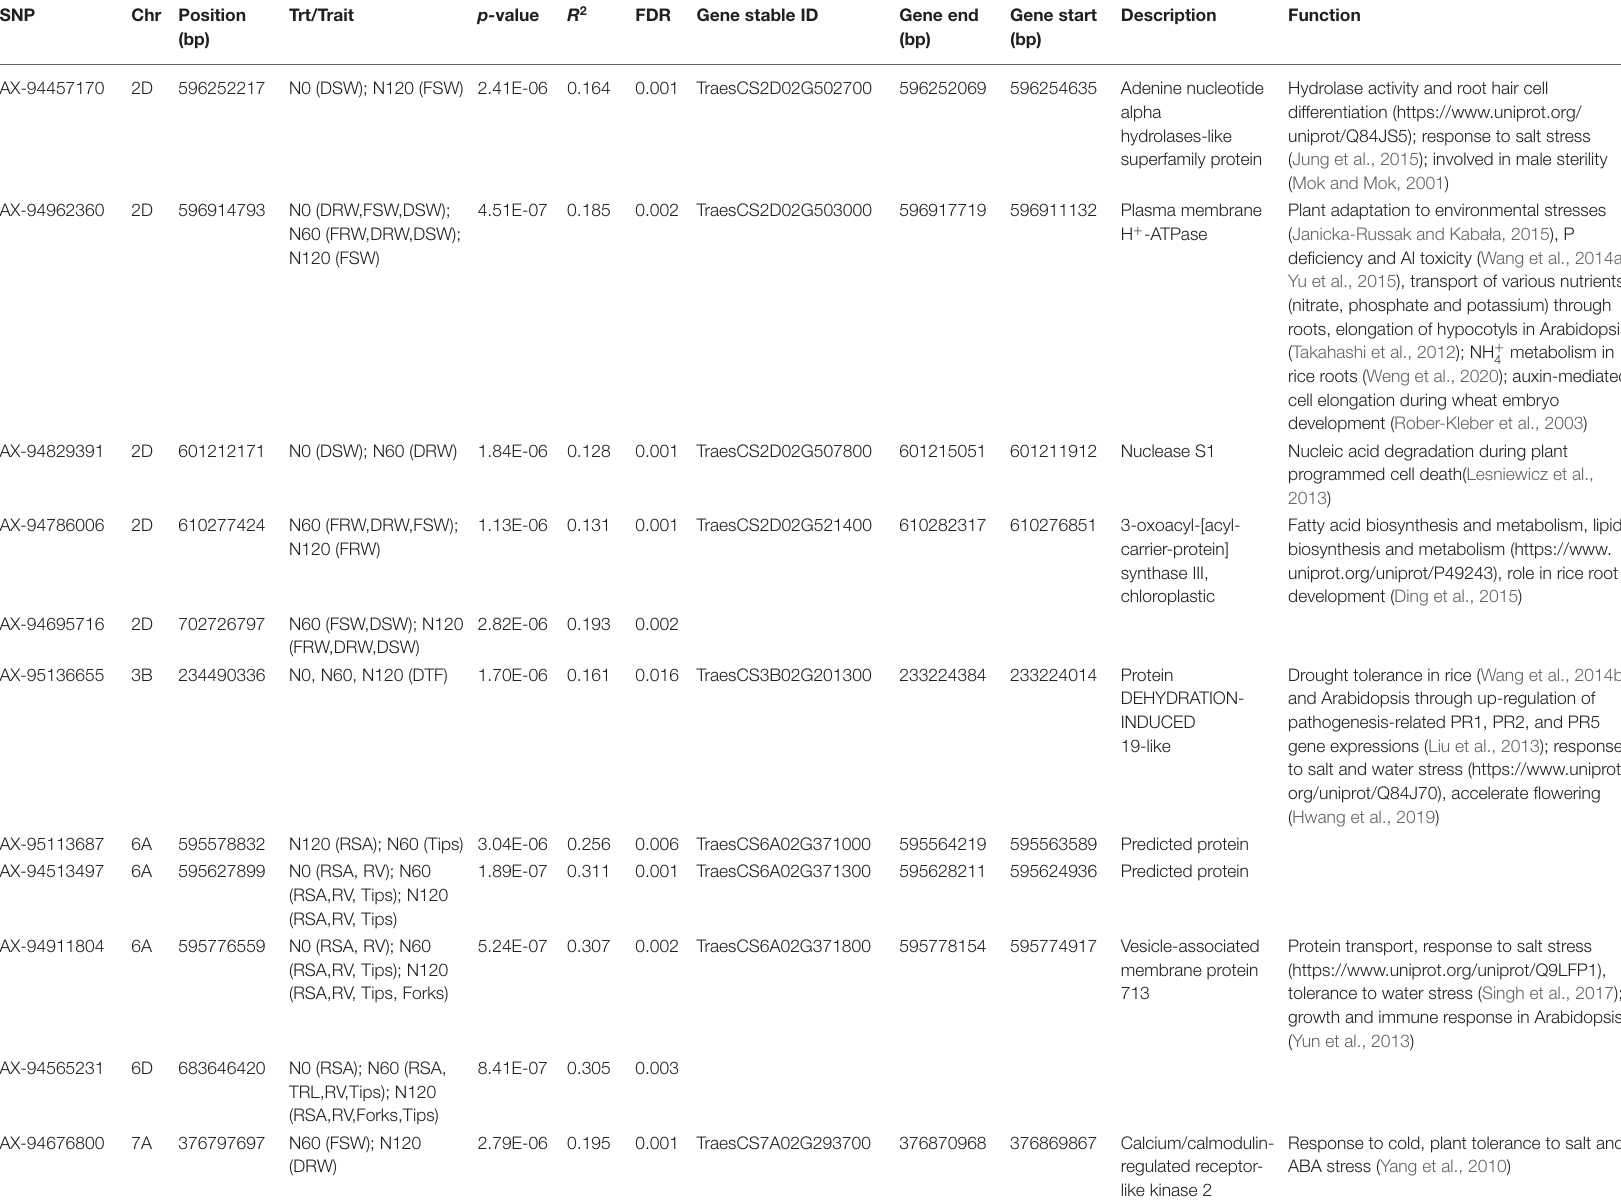
p-value: significance level of marker-trait association; R 2 : percent phenotypic variance explained by the SNP; FDR: false discovery rate, p-value, R 2 and FDR is represented as the mean value across